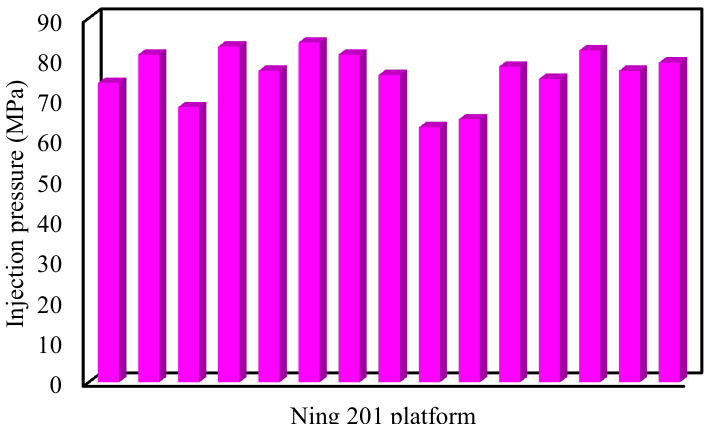
Figure 10. Fracturing injection pressure of 15 deformed casing wells in the Changning 201 platform.